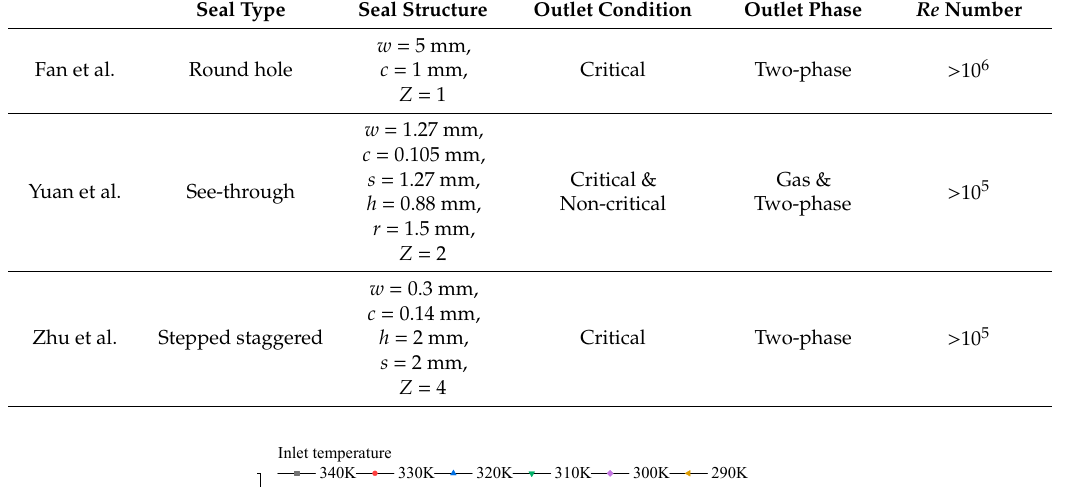
Table 7. The experiment details of di ff erent labyrinth seals compared in this paper.